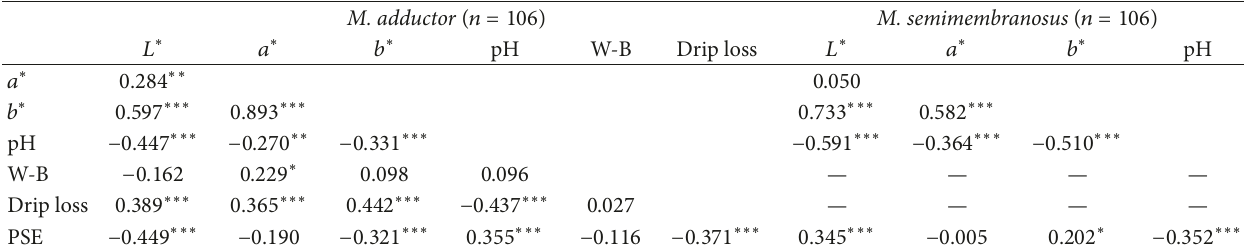
Table 4: Correlation coefficients and levels of significance in PSE and physical parameters. The parameters were subjected to a correlation analysis (Pearson’s coefficient) in order to determine potential statistical relationships between PSE and colour, pH, Warner-Bratzler shear force, and drip loss in m. adductor (AD) and m. semimembranosus (SM)